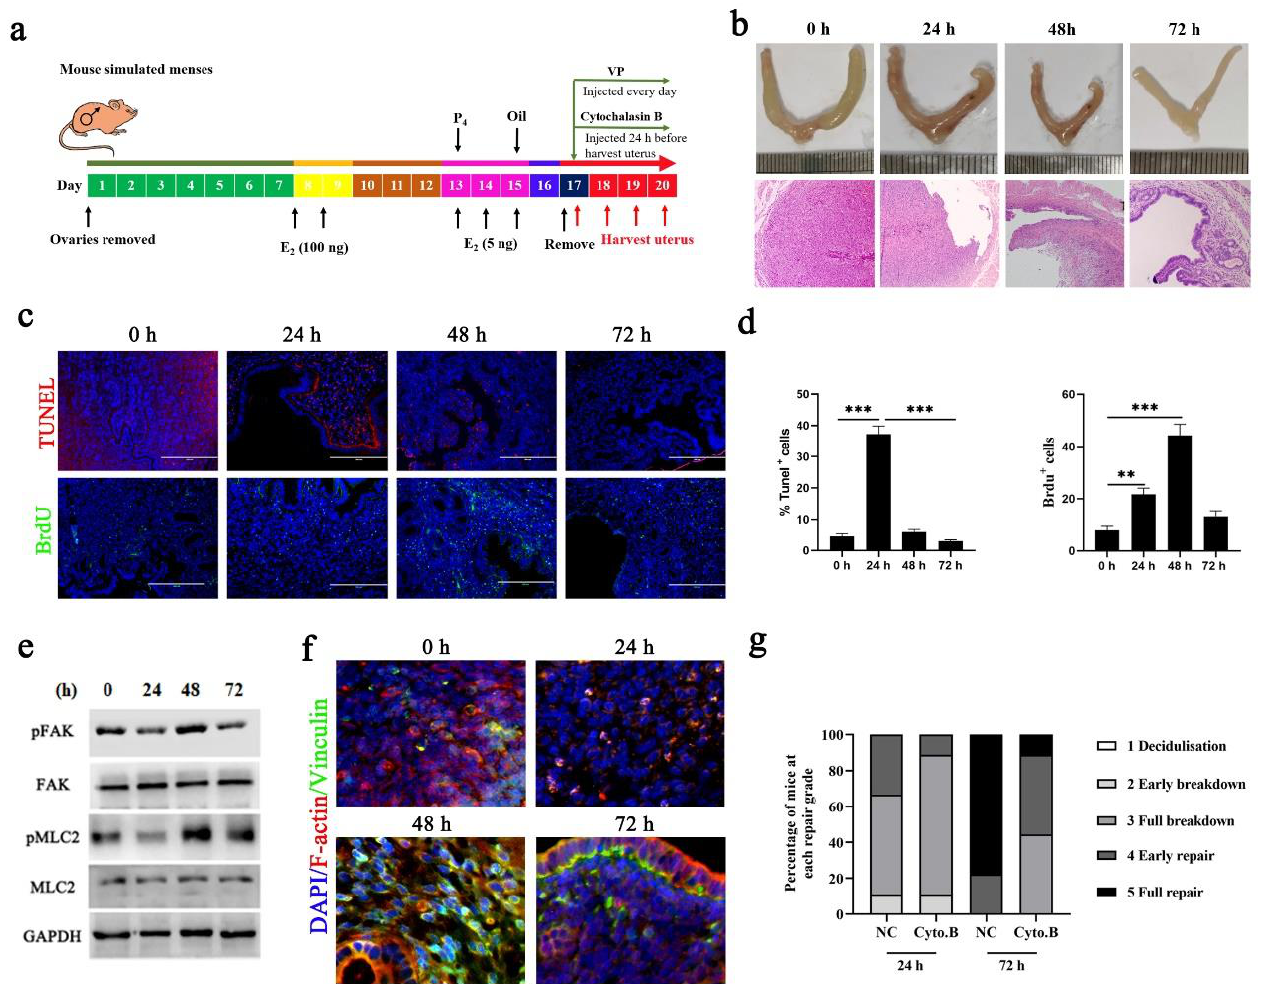
Figure 1. ECM stiffening features of the endometrium in a mouse model of simulated menses . ( a ) Diagram depicting the murine model of simulated menstruation. E2 17- β -estradiol, P4 proges- terone. Timed to 0 h, 24 h, 48 h and 72 h based on P4 withdrawal time. ( b ) Representative whole uterus images (top) and histopathological images of paraffin-embedded mouse uterine sections (bottom, n = 2). Scale bar: 400 µ m. ( c , d ) Representative images of uterine sections stained with TUNEL (top, n = 2) and BrdU (bottom, n = 2) and quantification of TUNEL+ and BrdU+ positive cells (( d ), n = 5). Scale bars, 200 µ m. The data are presented as mean ± SEM. ** p < 0.01; *** p < 0.001. ( e ) Western blot analysis of pFAK, FAK, pPMLC2 and pMLC2 expression. GAPDH was used as a loading control. ( f ) Representative images of vinculin and F-actin in mouse uterine sections. Scale bar, 20 µ m. n = 4. ( g ) Endometrial histological breakdown/repair score at 24 h and 72 h in mice treated with DMSO and Cyto. B. Graphs represent the percentage of mice at each histological grade per experimental group. n = 9. Experiments were repeated n times with duplicate biological